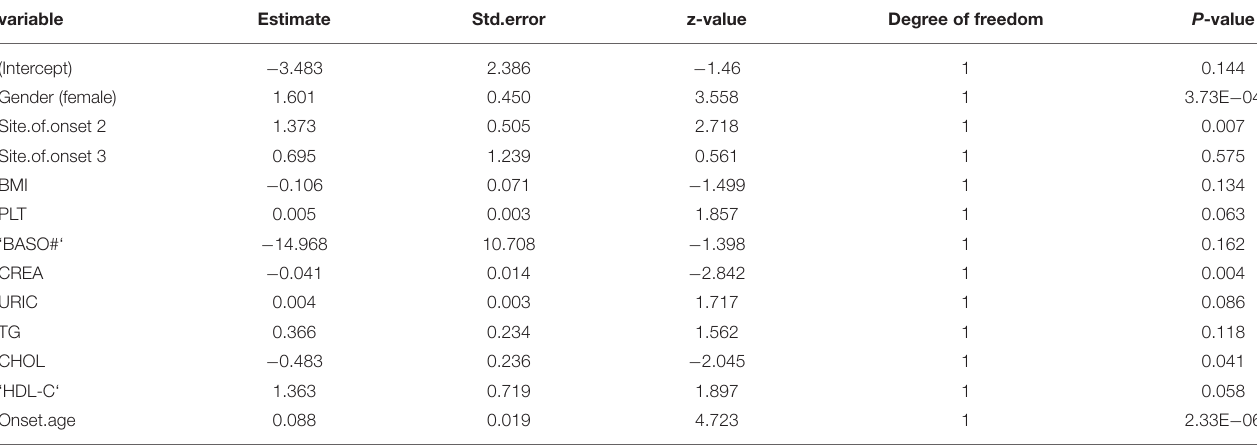
TABLE 2 | Variable in the prediction model by backward stepwise regression method combined with Akaike information criterion (AIC) for logistic regression equation. variable